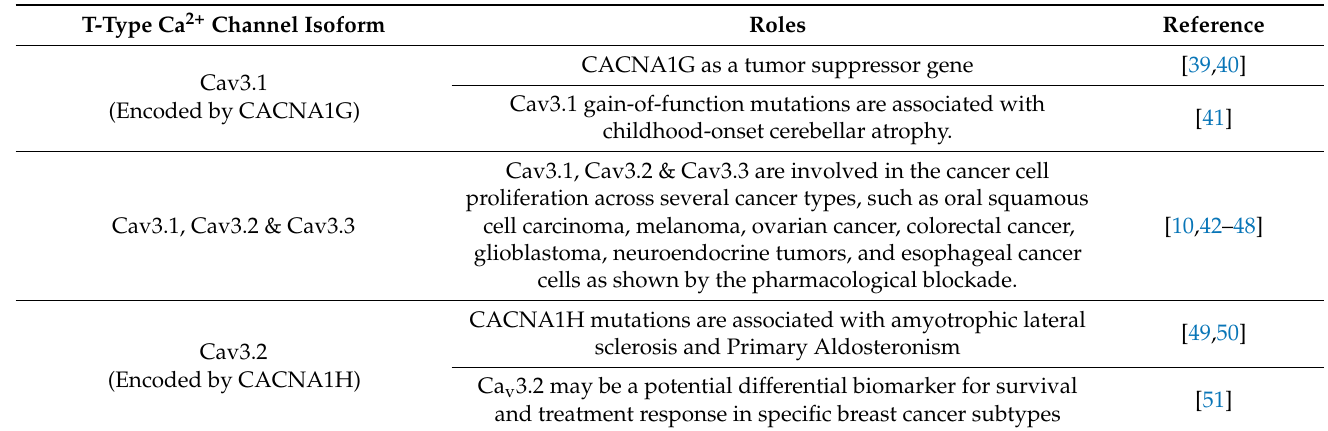
Table 2. Pathological roles of T-type Ca2+